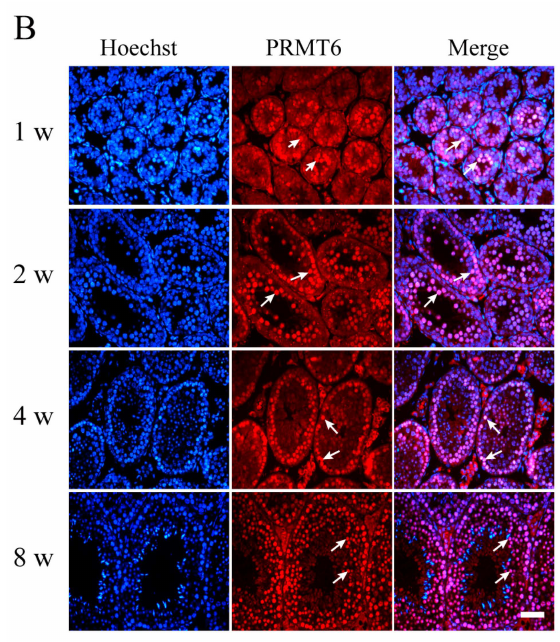
Figure 2. The expression of Prmt6 mRNA and PRMT6 protein during mouse testes development. ( A ) RT-qPCR analysis was used to detect Prmt6 mRNA in developing postnatal mouse testes. The relative expression of Prmt6 at different stages of testes development was compared to one week (w). Gapdh was used as an internal control. Data are expressed as the mean ˘ SD ( n = 5); ( B ) Immunofluorescence analysis was used to determine the localization of PRMT6 in mouse testes using a PRMT6 antibody (red). The nuclei of cells were labeled with Hoechst 33342 (blue). Purple represented the merging color of red and blue. Arrow: spermatogonia or spermatocytes. Bar = 50 µ m.